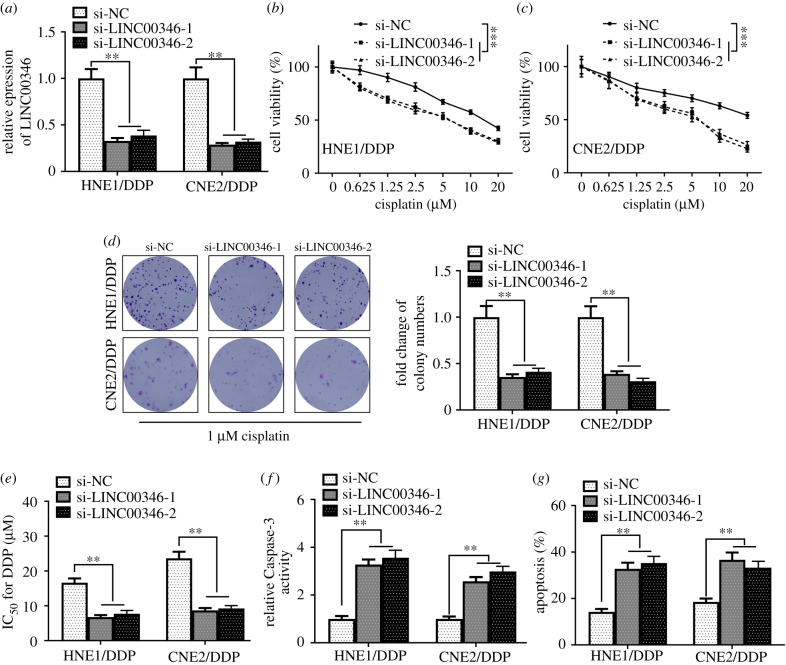
LINC00346 inhibition sensitizes NPC cells to cisplatin. (a) Real-time PCR analysis of LINC00346 in CR NPC cells (CNE2/DDP and HNE1/DDP) transfected with LINC00346 siRNAs (si-LINC00346-1, si-LINC00346-2) or negative control siRNA (si-NC). (b,c) HNE1/DDP and CNE2/DDP cells transfected with LINC00346 siRNAs or si-NC were treated with different doses of cisplatin for 48 h and analysed with CCK-8 assay. (d) Colony formation assay of HNE1/DDP and CNE2/DDP cells treated with 1 µM cisplatin and transfected with LINC00346 siRNAs or si-NC. (e) HNE1/DDP and CNE2/DDP cells transfected with LINC00346 siRNAs or si-NC were treated with various concentrations of cisplatin for 48 h to determine the IC50 of cisplatin. (f,g) Apoptotic rate of HNE1/DDP and CNE2/DDP cells transfected with LINC00346 siRNAs or si-NC with the cisplatin treatment (1 µM) was measured by Caspase-3 activity assay and histone/DNA ELISA. The data show the mean ± s.d. **p < 0.01; ***p < 0.001.